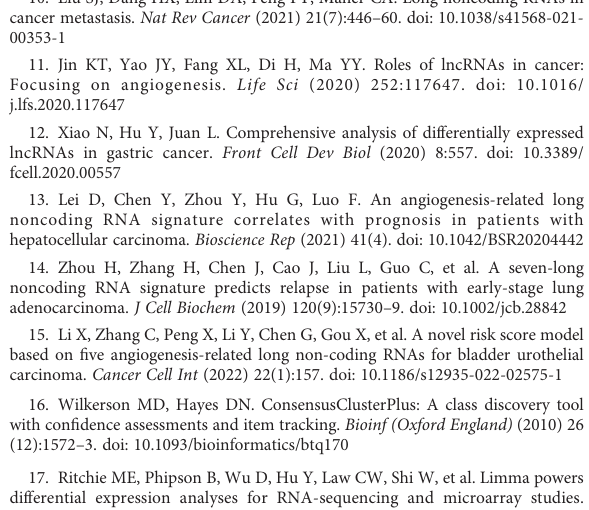
SUPPLEMENTARY FIGURE 1 Flow chart for the research. SUPPLEMENTARY FIGURE 2 Effects of TTN gene mutation on angiogenesis-related genes. SUPPLEMENTARY FIGURE 3 Effects of TP53 gene mutation on angiogenesis-related genes. SUPPLEMENTARY FIGURE 4 Kaplan – Meier analysis on six angiogenesis-related lncRNAs based on TCGA database. SUPPLEMENTARY FIGURE 5 The in fl uence of six angiogenesis-related lncRNAs knockdown on CCK8